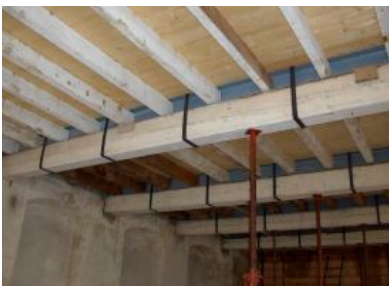
Figure 19. Reinforcement of a timber beam using a stainless steel H-shaped beam applied on the compressed area.